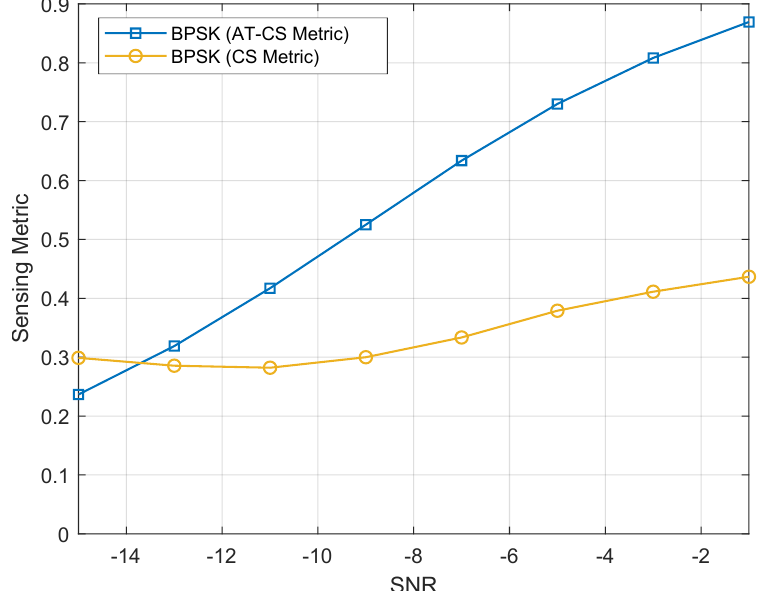
Figure 3. Sensing metrics as a function of the SNR for the conventional cyclostationary and angle-time cyclostationary